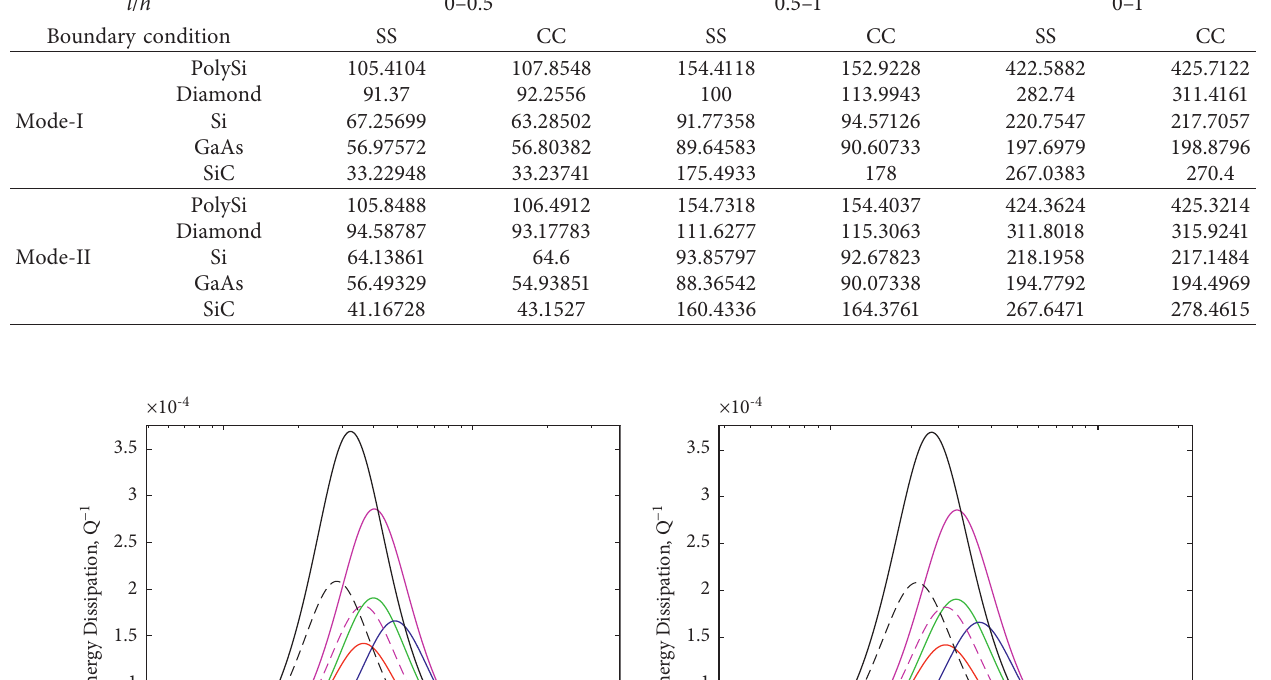
Table 3: Percentage increase in Q